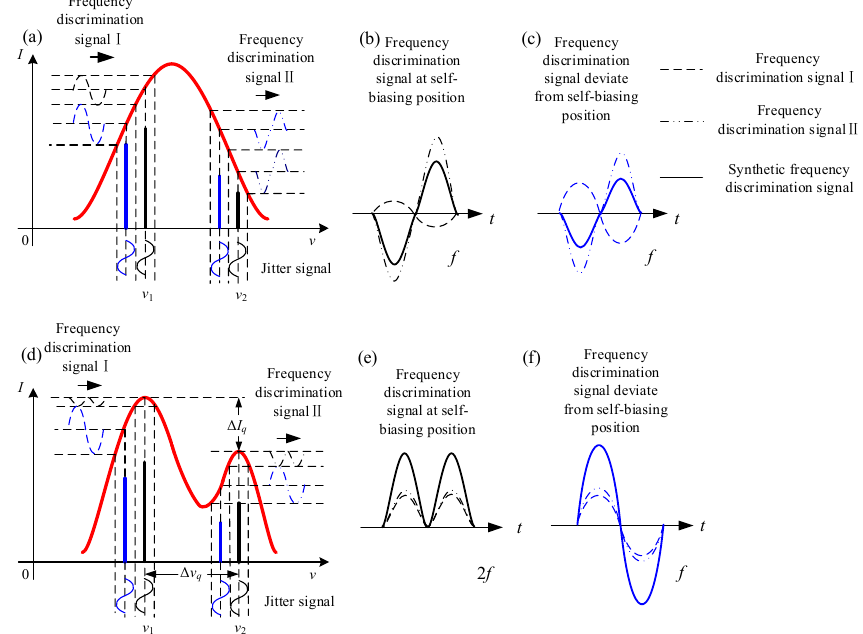
Figure 9. Contrast diagram of frequency stabilization under different profiles of the intensity tuning curve. ( a ) Similar Gaussian curve, with the frequency discrimination signals in the self ‐ biasing state; ( b ) similar Gaussian curve, with the synthetic discrimination signals in the self ‐ biasing state; ( c ) similar Gaussian curve, with the frequency discrimination signals deviating from the self ‐ biasing position; ( d ) modulated profile, with the frequency discrimination signals in the self ‐ biasing state; ( e ) double ‐ peak profile, with the synthetic discrimination signals in the self ‐ biasing state; ( f ) double ‐ peak profile, with the frequency discrimination signals deviating from the self ‐ biasing position.